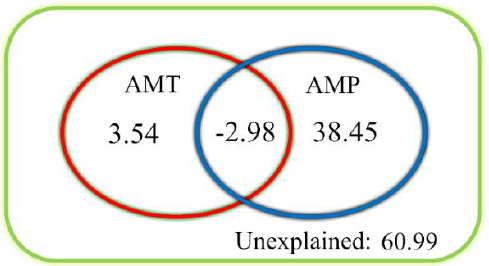
Figure 5. Relative contributions of annual mean temperature (AMT) and annual mean precipitation (AMP) to the dynamic of normalized difference vegetation index from 1982 to